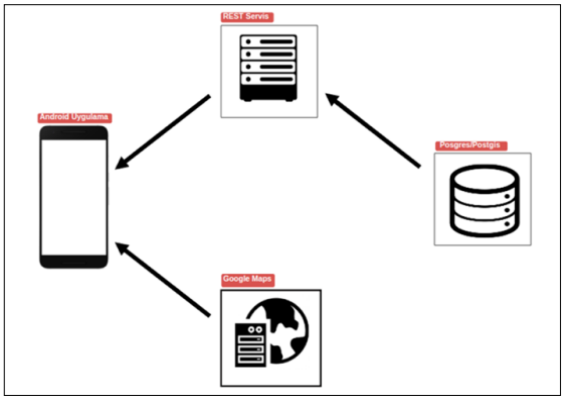
Figure 2. Architecture diagram of the Smart Real Estate mobile application